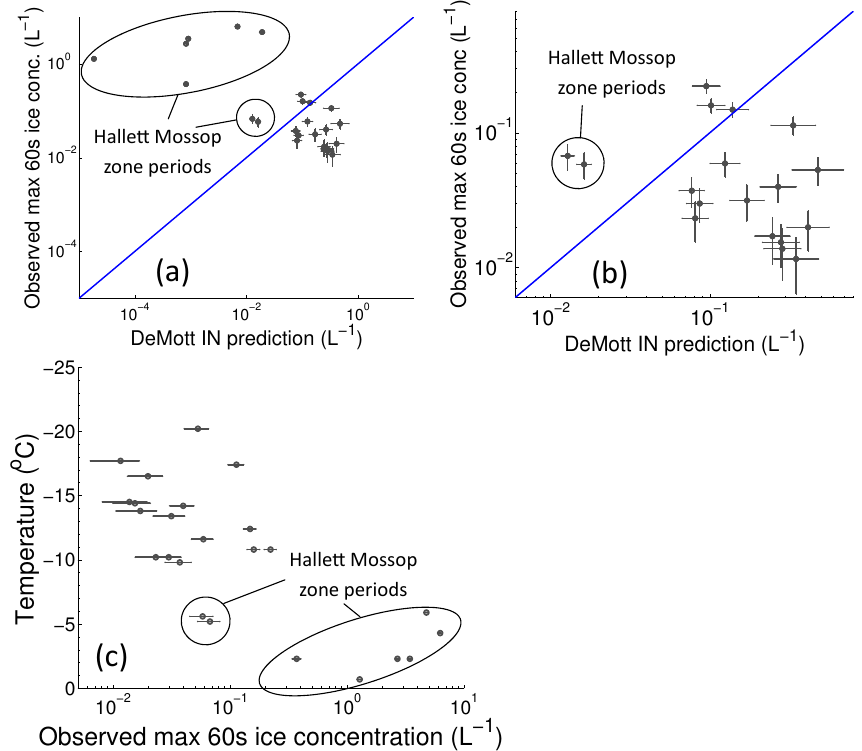
Fig. 11. ( a and b ) – Observed maximum 60s ice concentrations from the different periods listed in Table 1 plotted against the IN concentration predicted by the DeMott et al. (2010) parameterization. The vertical error bars represent the standard Poisson uncertainty in the measured ice concentrations, whilst the left and right-hand sides of the horizontal error bars represent the IN values obtained if, respectively, half and double the observed aerosol concentrations are used in the parameterization. See the text for more details. (a) shows the points for all of the ice flight segments and (b) is in close up around the points from the heterogeneous ice nucleation regions. (c) shows the observed maximum 60s ice concentrations (with Poisson errors) plotted against the observation temperature. Periods located in the Hallett Mossop ice multiplication regions are